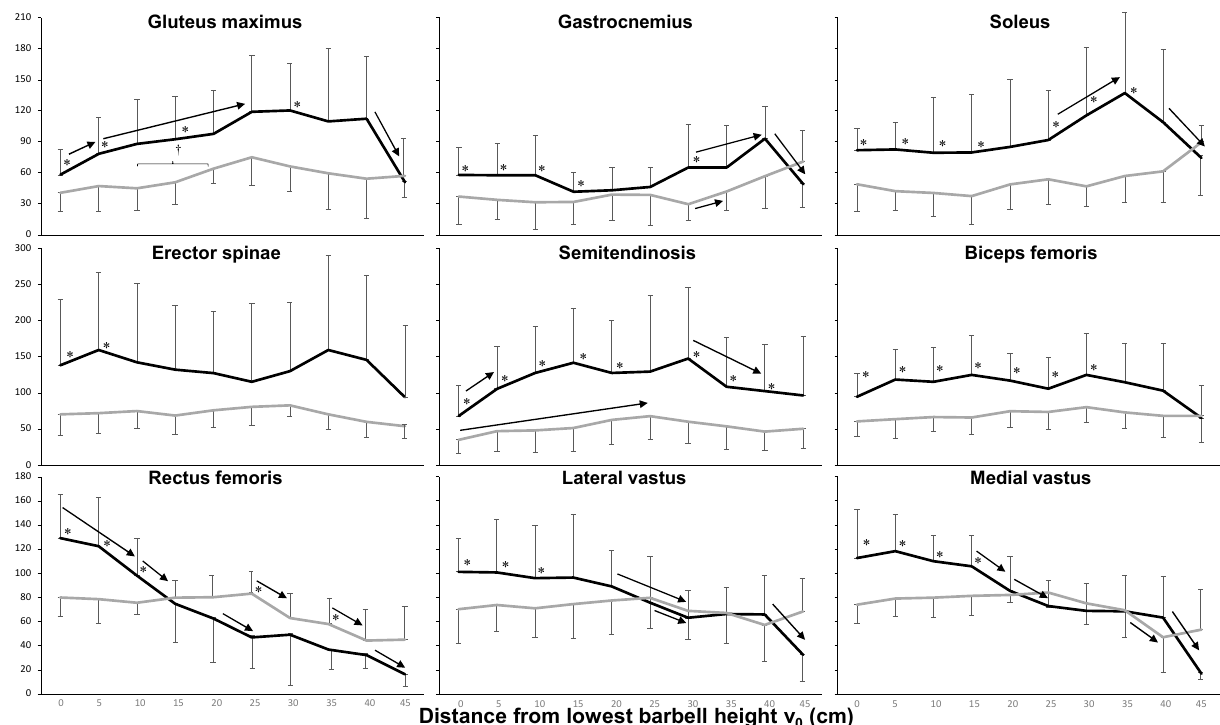
Figure 3. Mean ( ± standard deviation) muscle activities of the nine measured muscles at the different vertical distances from the lowest barbell position in the one-repetition maximum (1-RM) squat attempt and the isometric contractions. * Indicates a significant difference ( p < 0.05) in muscle activity between the 1-RM and isometric attempts at this distance. → Indicates a significant difference ( p < 0.05) in force output between these two distances for this condition.